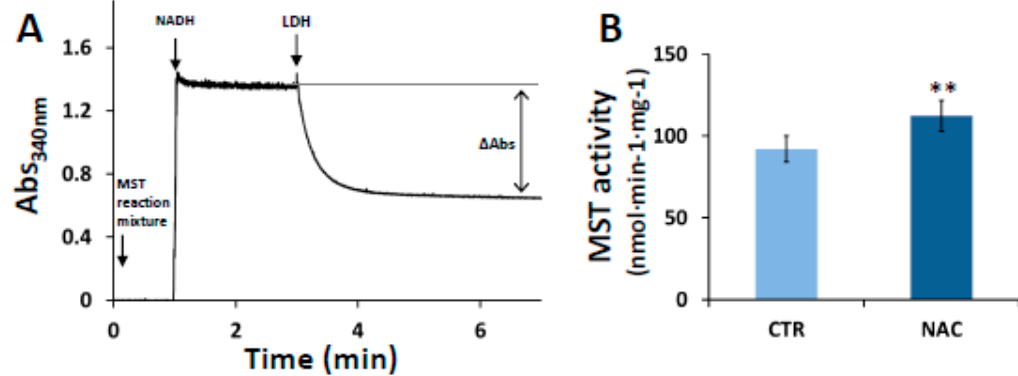
Figure 2. MST activity in cell lysates. (Panel A ) Representative spectrophotometric trace of MST activity measured by LDH-coupled assay. The measurement was carried out at 37 ◦ C under stirring conditions (see Materials and Methods). The starting solution contained the deproteinized MST activity mixture in Tris-HCl 100 mM (pH 8.0) containing 6.4 mM NEM to block unreacted 3MP. After addition of 224 µ M NADH followed by addition of 7 U LDH, the pyruvate concentration was estimated from the NADH being oxidized accounting for the decrease in absorbance measured at 340 nm. (Panel B ) MST activity normalized to total protein. Data represent the mean value ± SD of 5 repeats. ** p ≤ 0.01.